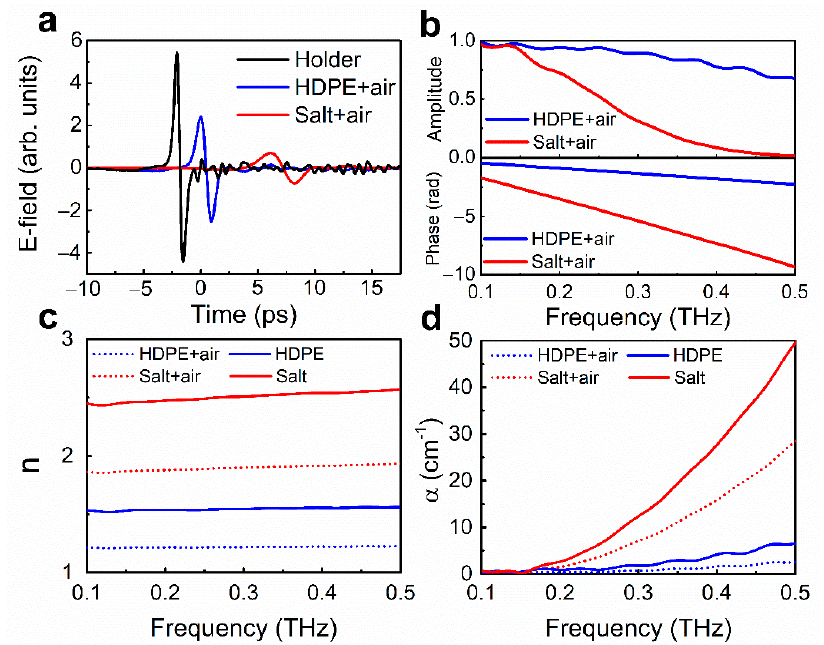
Figure 2. Extraction of refractive indices and absorption coefficients of HDPE and salt from terahertz transmittance. ( a ) Terahertz time traces of bare holder (black), HDPE-air (blue), and salt-air (red). ( b ) Amplitude (top) and phase (bottom) of HDPE-air (blue), and salt-air (red) normalized by the reference, as a function of frequency. ( c , d ) Extracted refractive indices ( c ) and absorption coefficients ( d ) of HDPE (blue) and salt (red), calculated by employing effective medium theory (LLL model). Dotted- and solid-lines correspond to cases of the samples before and after air consideration, respectively.